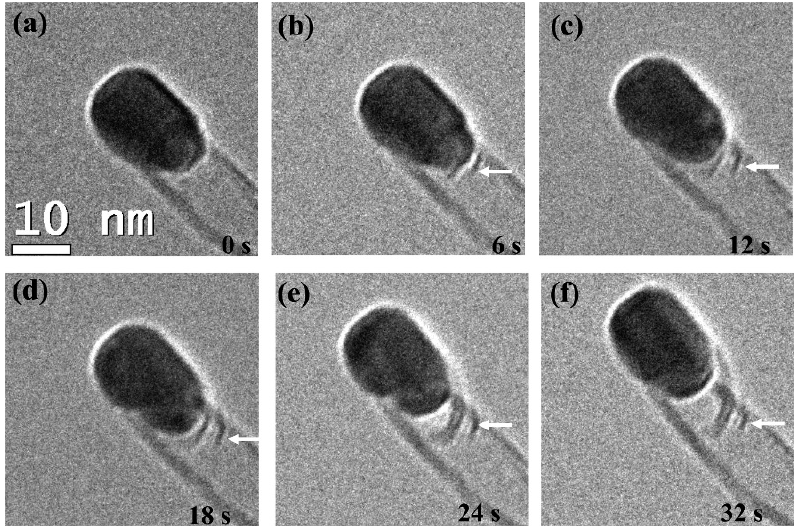
Figure 17. ( a – f ) A series of TEM images showing the formation BCNTs with incomplete knots within a 6 s interval [62]. a 6 s interval